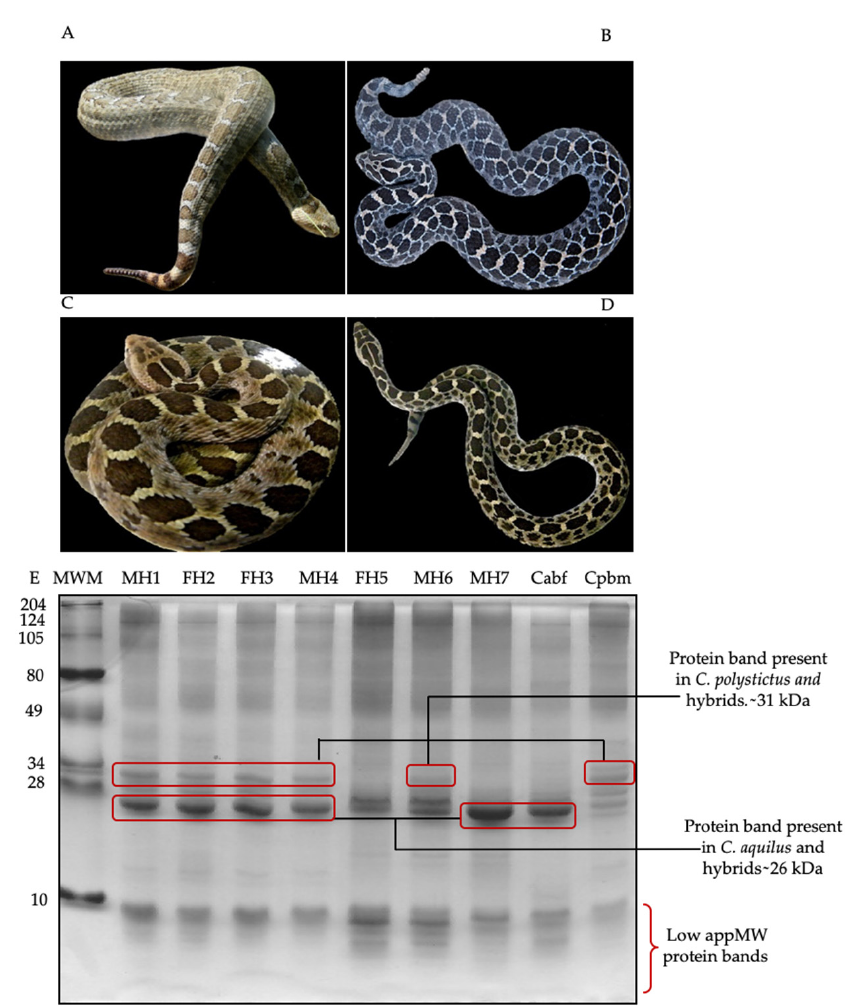
Figure 1. Dorsal banding pattern and protein profile of 20 µ g of venom in a 12% SDS-PAGE. ( A ) C. aquilus (Cabf), ( B ) C. polystictus (Cpbm), ( C ) male hybrid 1 (MH1), ( D ) male hybrid 6 (MH6), ( E ) protein pattern. Hybrids of the first hybridization event (four years old): MH1, FH2, FH3, and MH4; hybrids of the second hybridization event (three years old): FH5, MH6, and MH7; C. aquilus biological father (Caqbf); C. polystictus biological mother (Cpbm). Molecular weight markers (MWMs) are indicated on the left side. M, male; F, female. Table 1. Comparison between number of scales for C. aquilus , C. polystictus , Cabf, Cpbm, and the hybrids.